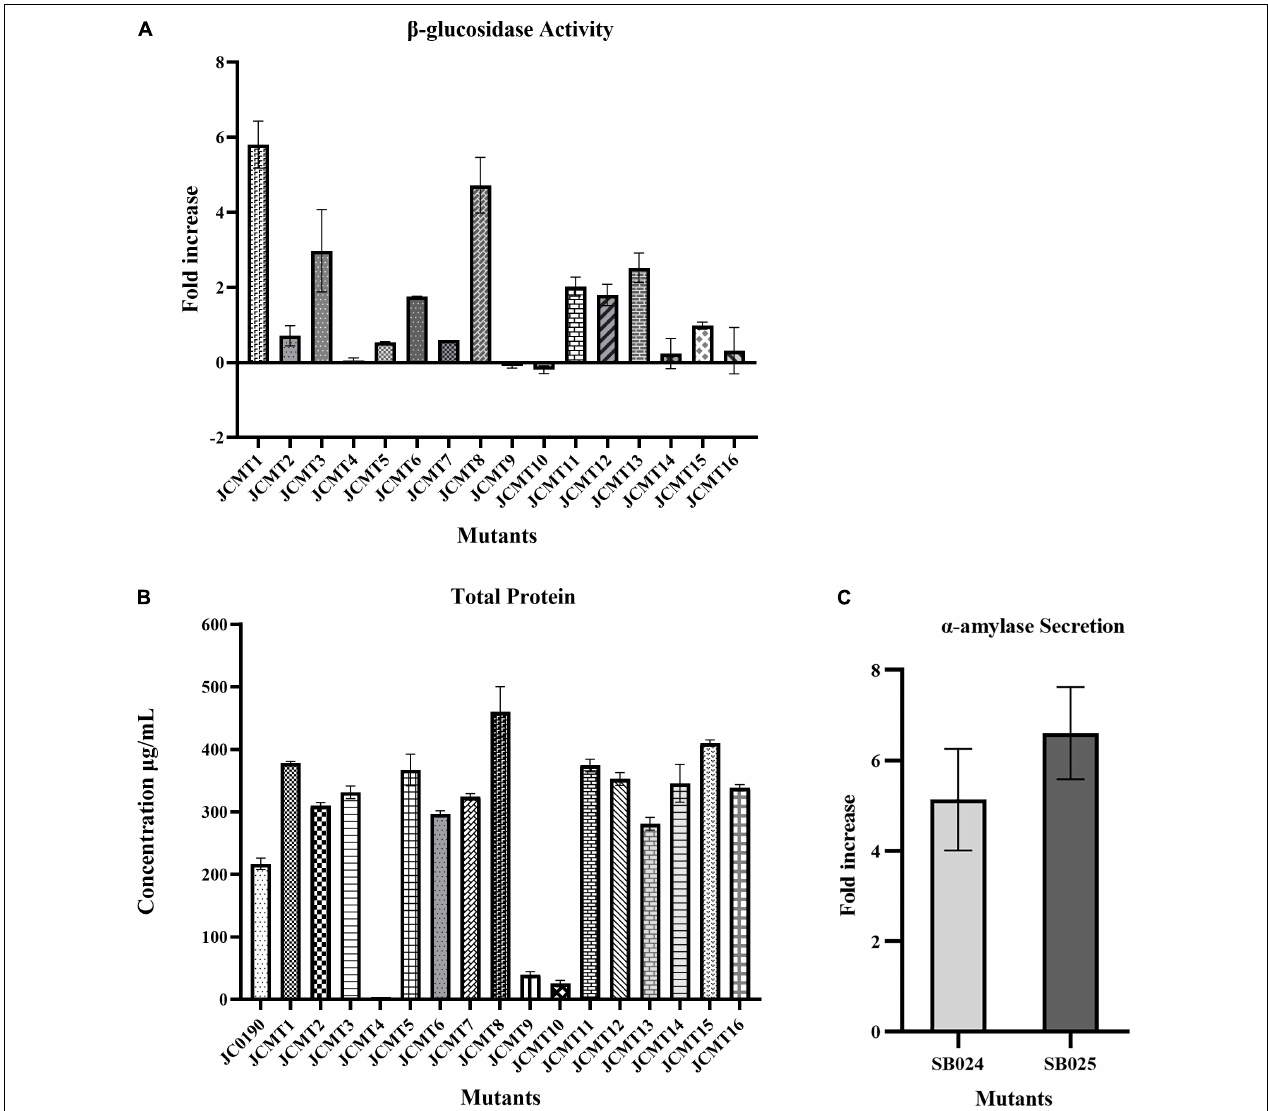
FIGURE 5 | Protein secretion capacity of selected mutant strains: (A) β -glucosidase activity: fold increase in the relative fluorescence activity of the mutant strains secreting β -glucosidase in comparison to the reference strain JC0190. (B) Total protein: total protein content of the reference and mutant strains in the supernatants. The protein content of mutant 4 is around 4 µ g and hence negligible in the graph. (C) α -Amylase secretion: fold increase in the α -amylase enzyme units of the strains SB024 and SB025 derived from mutants JCMT1 and JCMT8, respectively, compared to the reference strain